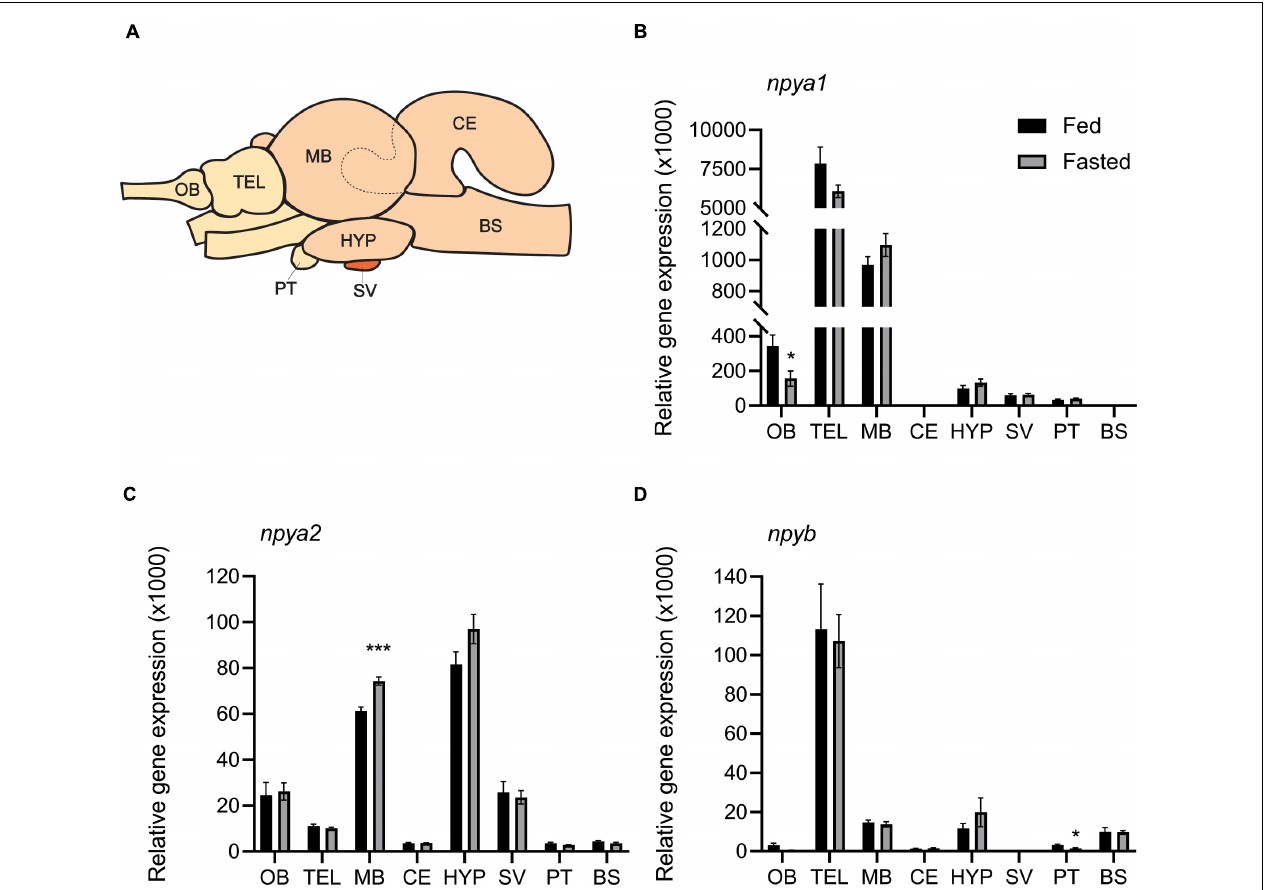
FIGURE 3 | (A) Schematic representation of Atlantic salmon brain, showing dissection of the eight brain regions used for gene expression analysis: olfactory bulb (OB), telencephalon (TEL), midbrain (MB), hypothalamus (HYP), cerebellum (CE), saccus vasculosus (SV), pituitary (PT), and brain stem (BS). The dashed line represents the dissected area of the CE inside the MB. Effects of 4 days of fasting on the mRNA expression levels of (B) npya1 , (C) npya2 , and (D) npyb in the eight regions of Atlantic salmon brain. Black and gray columns represent fed and fasted fish, respectively. n = 6 for both groups and for all regions except in saccus vasculosus ( n = 4) and in instances where technical or statistical outliers have been removed (refer to Supplementary Table 5 ). Values are expressed as copy number per ng total RNA used in the reaction normalized using the geometric mean of the reference genes s20 and β -actin-actin. Bars represent mean ± SEM. Two-tailed t -test was performed to assess whether there were statistically significant differences between the fed and fasted group for each brain region. Asterisks (*) indicate statistically significant difference (* p ≤ 0.05, *** p ≤